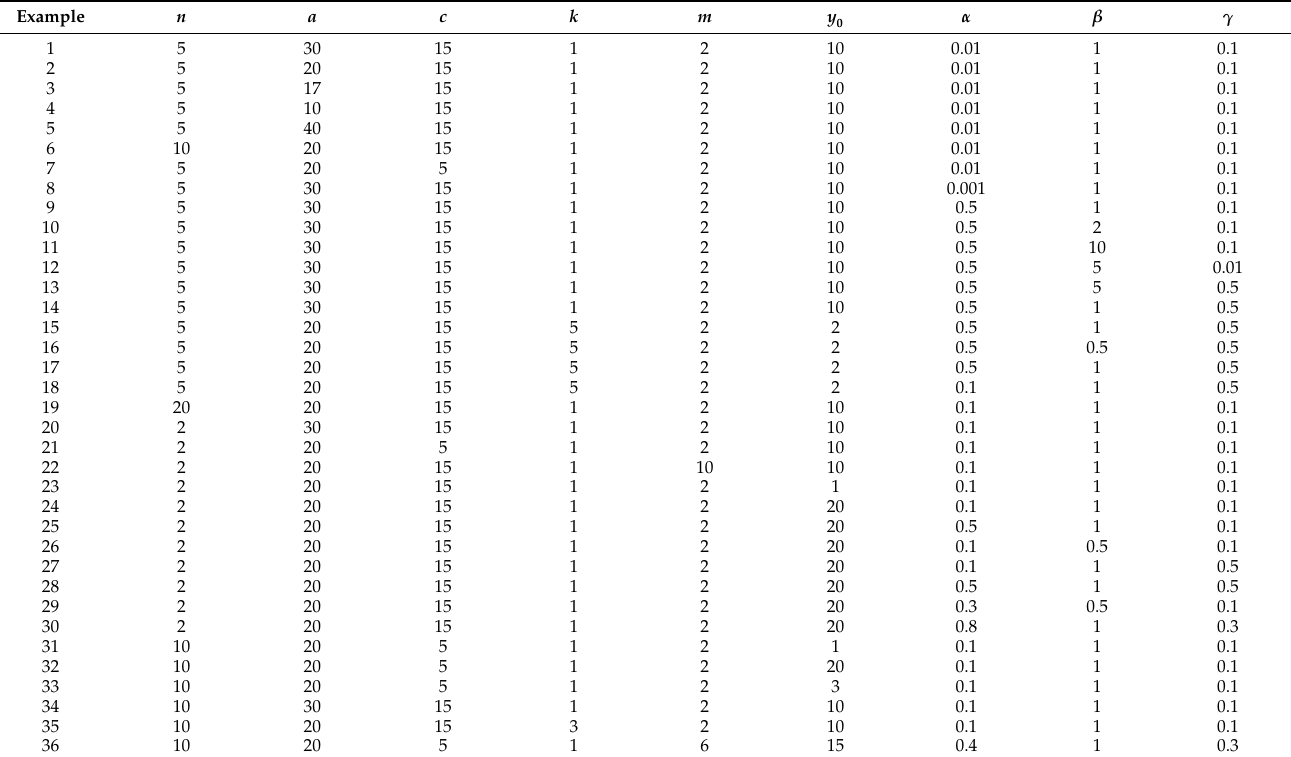
Table 6. Input data for symmetrical agents with consideration of the green